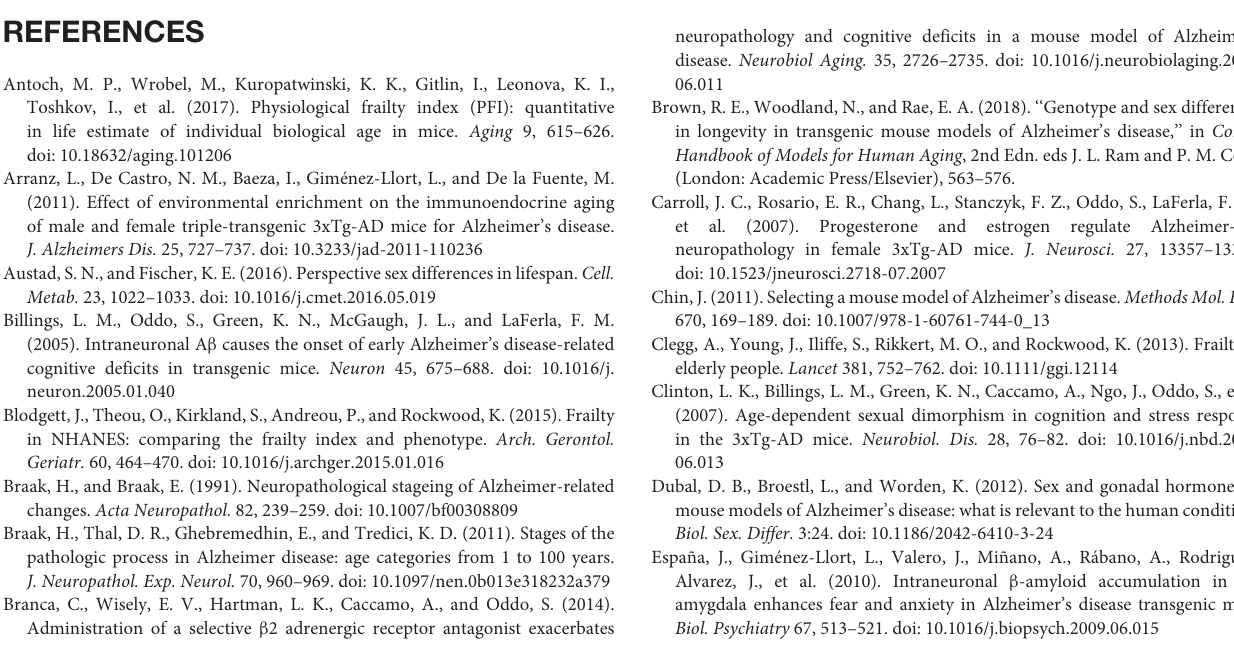
FIGURE S1 | Increasing FI scores are correlated with increasing age in male and female 3xTg-AD and WT mice. FI Score is exponentially correlated with age (days) for (A) WT males ( n = 84, r = 0.474, p < 0.0001), (B) 3xTg-AD males ( n = 35, r = 0.461, p < 0.0001), (C) WT females ( n = 91, r = 0.377, p < 0.0001) and (D) 3xTG females ( n = 62, r = 0.574, p < 0.0001). TABLE S1 | Causes of death or reason for euthanasia in WT and 3xTg-AD mice of both sexes. Numbers represent the number of mice in each category. Most mice were used in other experiments. TABLE S2 | Raw data used to construct a frailty index from wild-type and 3xTg-AD mice of both